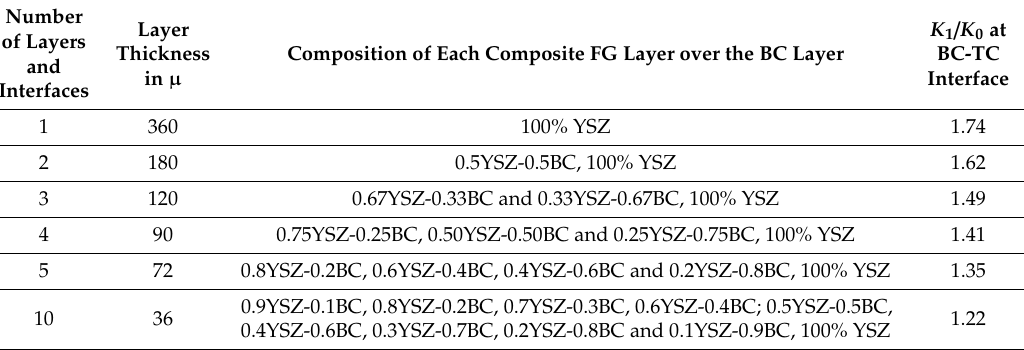
Table 2. Details of the YSZ TBC systems designed and considered for analysis.